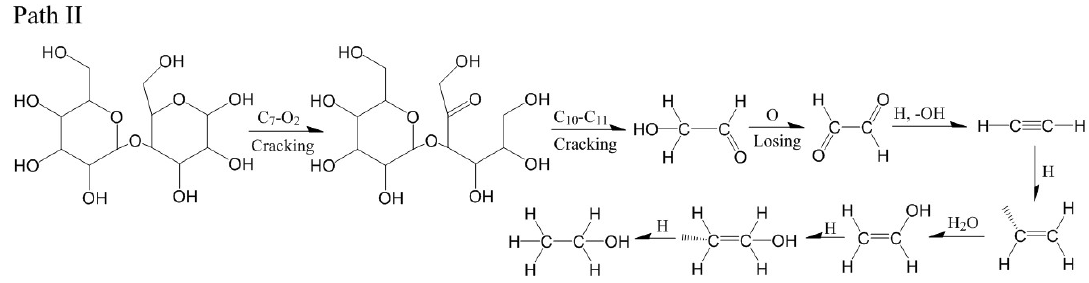
Figure 14. Relevant generation path II of ethanol at 2800 K.